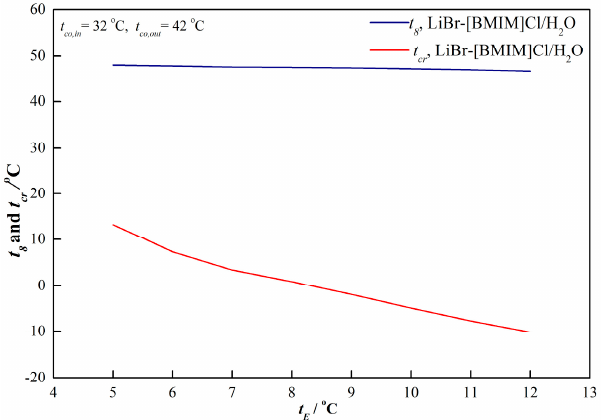
Figure 6. Variations of t 8 and t cr for LiBr–[BMIM]Cl / H 2 O with the evaporation temperature t E .